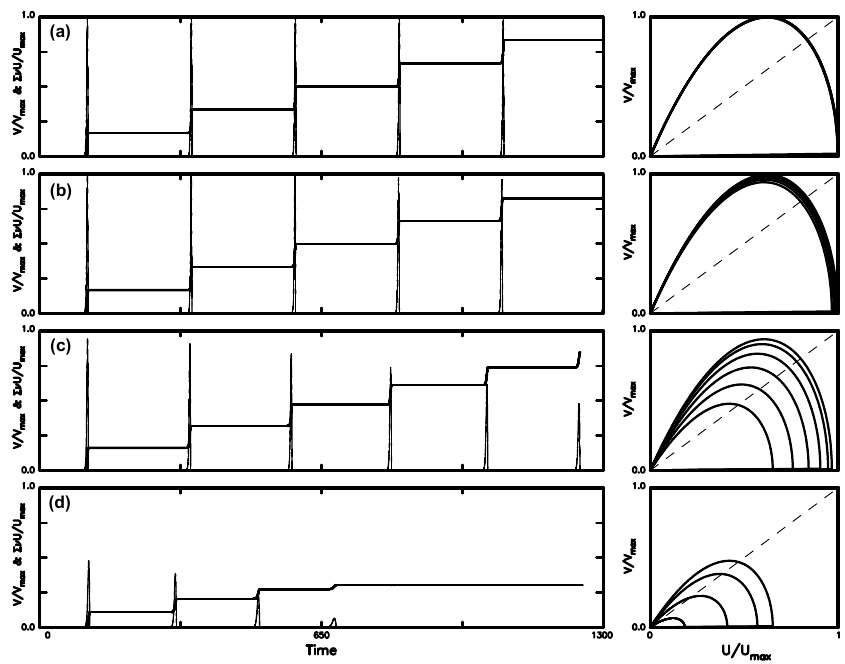
Figure 9. The time variations in V/V max (thin solid line) and cumulative slip (cid:54)U/U max (solid line) and the phase portrait of V/V max versus U/U max (solid line) for four values of C : (a) for C = 0.0001; (b) for C = 0.001; (c) for C = 0.01; and (d) for C = 0.05 when U co = 0.5 and η =